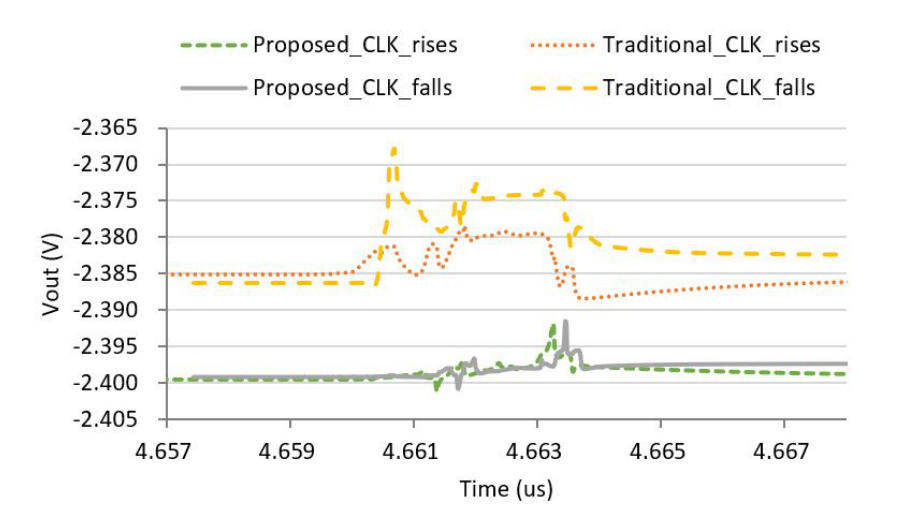
Figure 5. Simulation results of output voltages of proposed CP and traditional CP (The frequency of oscillator is 3 MHz and the VDD is 2.4 V).